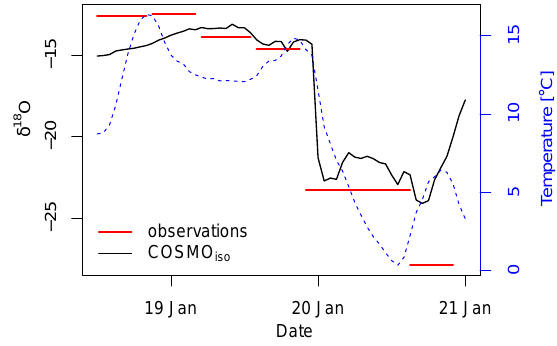
Fig. 7. Time series of δ 18 O in water vapour (in ‰) at station RDU (white cross in Fig. 1) from observations and the COSMO iso ref- erence simulation. Note the differing lengths of the periods over which the vapour has been sampled. The blue dashed line shows the simulated temperature. All COSMO iso data are taken from the lowest model level, approximately 10 metres above